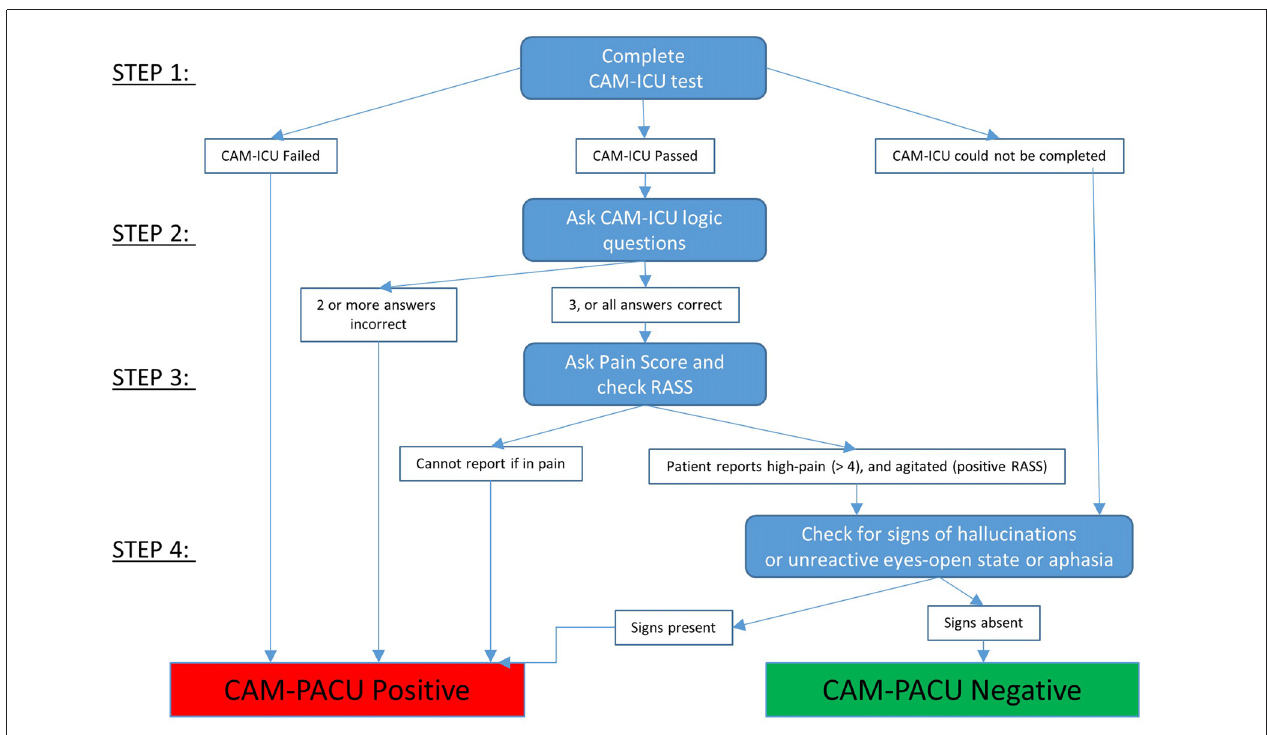
FIGURE 2 | The four step process of using the CAM-PACU test for delirium and disordered